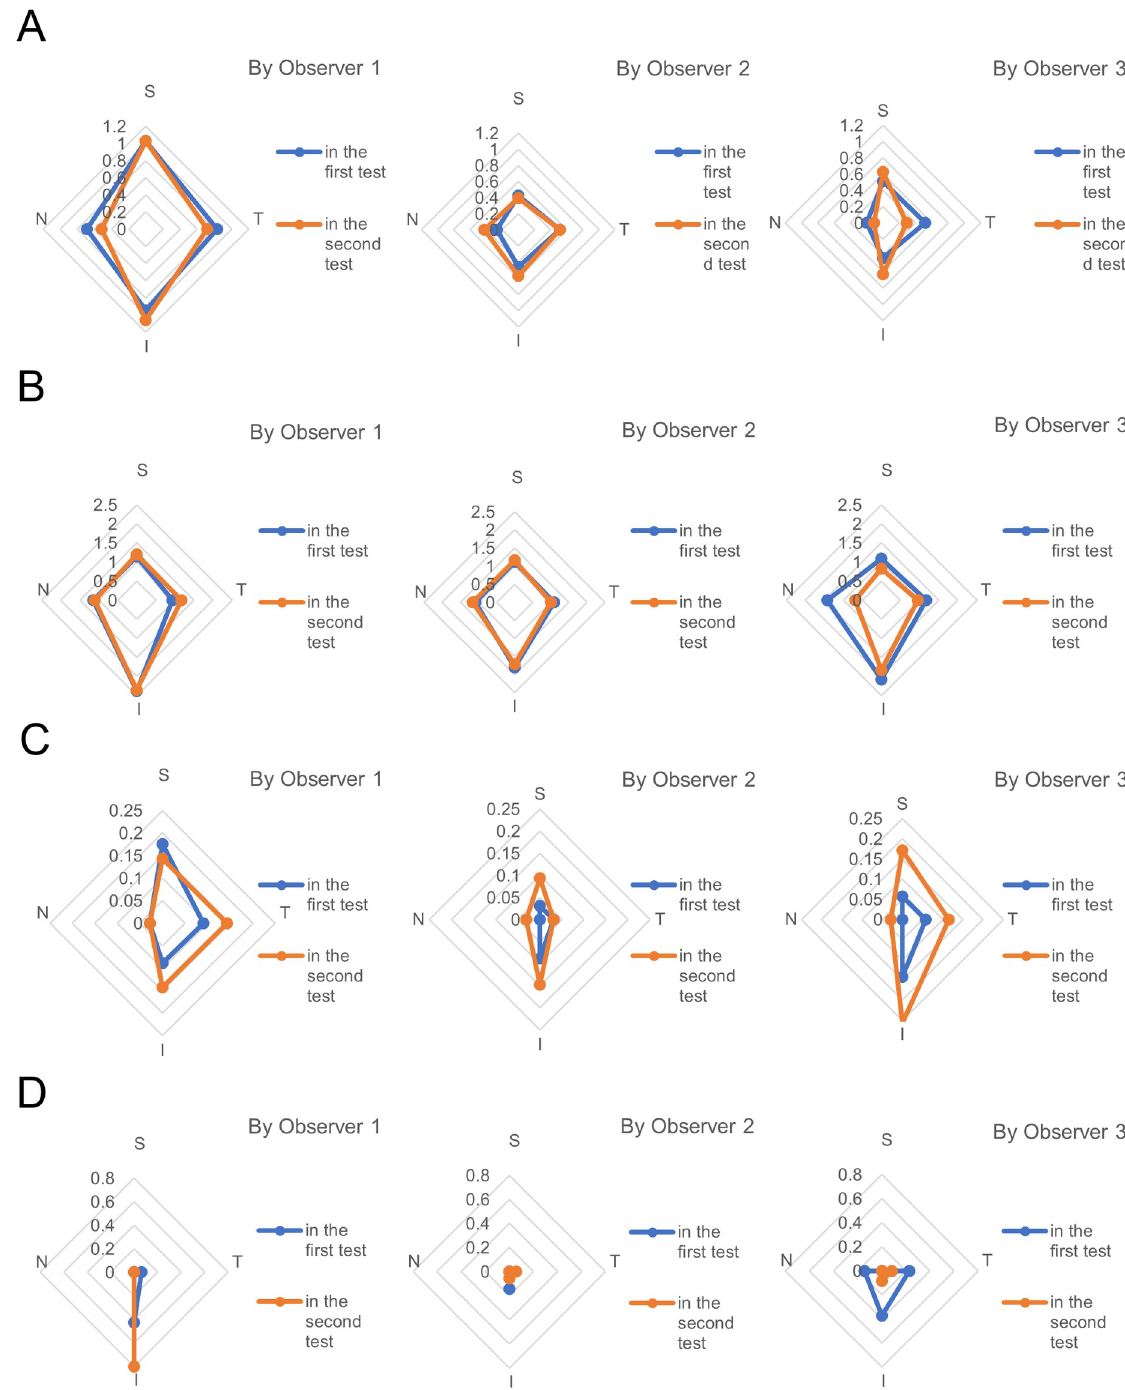
Fig 1. The radar charts of the mean distributions of iridocorneal angle evaluations during the first and second tests by three independent glaucoma specialists for visualizing intraobserver variabilities in (A) Scheie’s angle width grading (0 to 4), (B) Scheie’s angle pigmentation grading (0 to 4), (C) PAS detection (0 to 1), and (D) Sampaolesi line detection (0 to 1). S = superior; T = temporal; I = inferior; N = nasal.